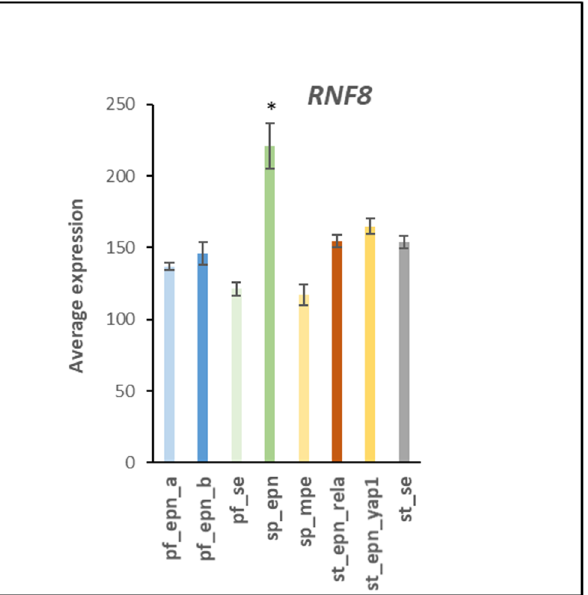
Figure 14. Elevated expression of E3 ligase RNF8 in the SP_EPN subtype (by Anova, F = 11.86, p = 1.28 × 10 − 12 ). * significantly different from all other groups by t -test p < 0.01. Dataset GSE64415.